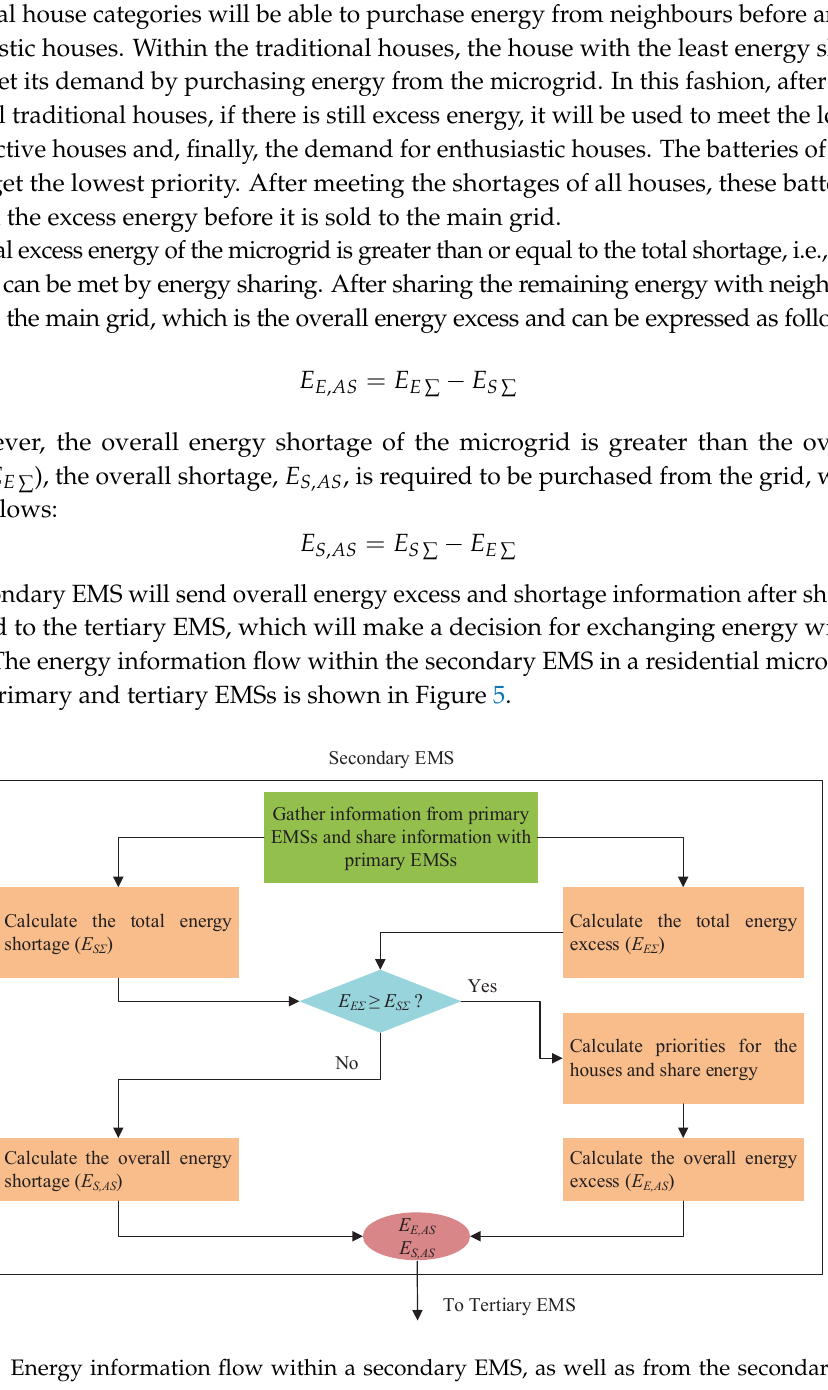
Figure 5. Energy information flow within a secondary EMS, as well as from the secondary to the primary and tertiary